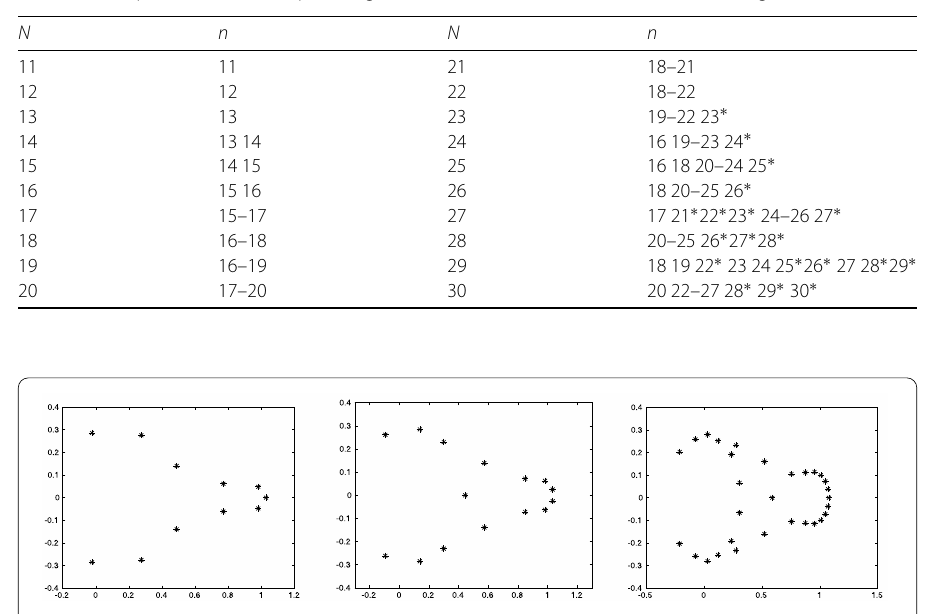
Figure 16 Eigenvalues of U n in the case of discrete weight functions for n = N = 11,15,30 (from left to right)